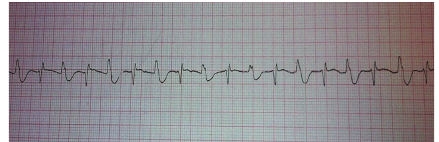
Figure 1: II lead ECG, in the Emergency Department, showing bidirectional